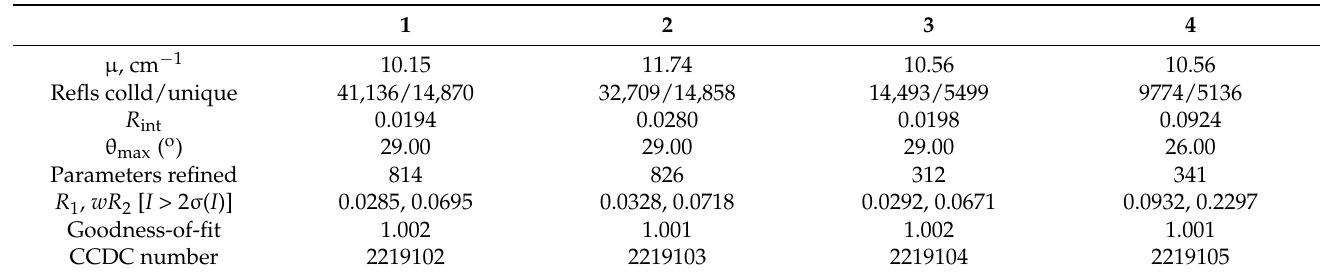
Figure S9: The dependence of ln( τ ) vs. T − 1 for 1 in a zero dc field; Figure S10: TG-DSC curves and mass spectra for complex 1 after drying in vacuum; Figure S11: IR (a) and Raman (b) spectra of the complex 1 ; Figure S12: TG-DSC curves and mass spectra for complex 2 after drying in vacuum; Figure S13: IR spectrum of the complex 2 ; Figure S14: Powder diffraction pattern for a dried sample of 2 ; Figure S15: IR spectrum of the complex 3 ; Figure S16: IR spectrum of the complex 4 ; Tables S1, S2, S3, S4: Hydrogen bond geometry in 1 , 2 , 3 , 4 , respectively; Table S5: Weiss temperatures in the complexes 1 – 4